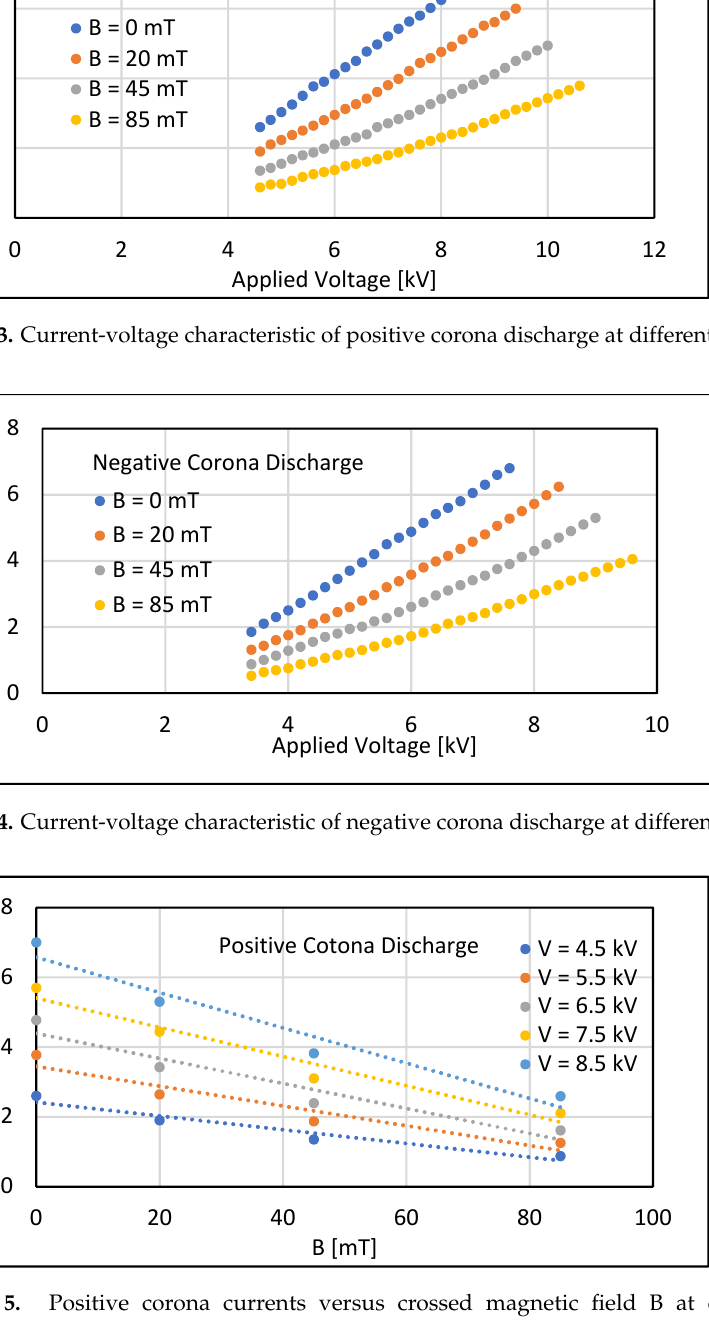
Figure 5. Positive corona currents versus crossed magnetic field B at different values of applied voltage. Figure 6. Negative corona currents versus crossed magnetic field B at different values of applied voltage.